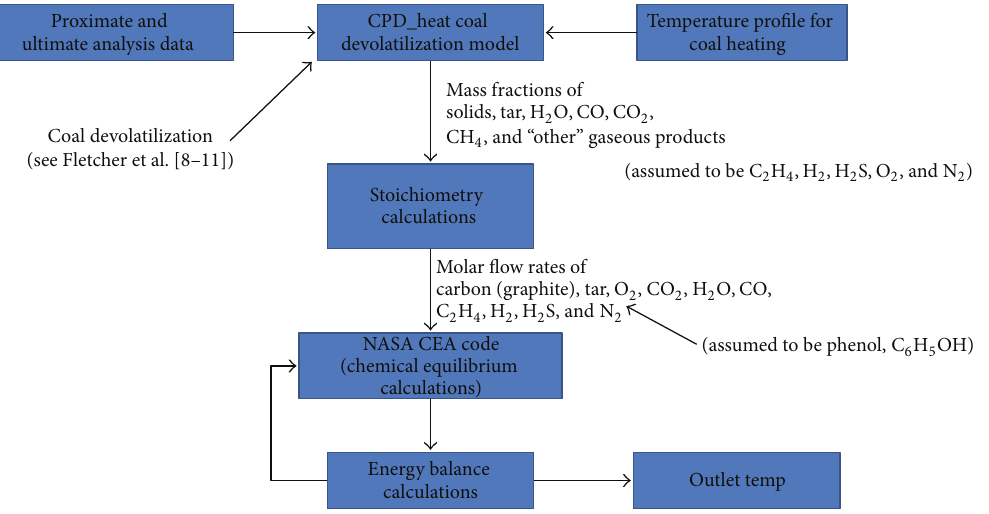
Figure 8: Reduced order model (ROM) computational